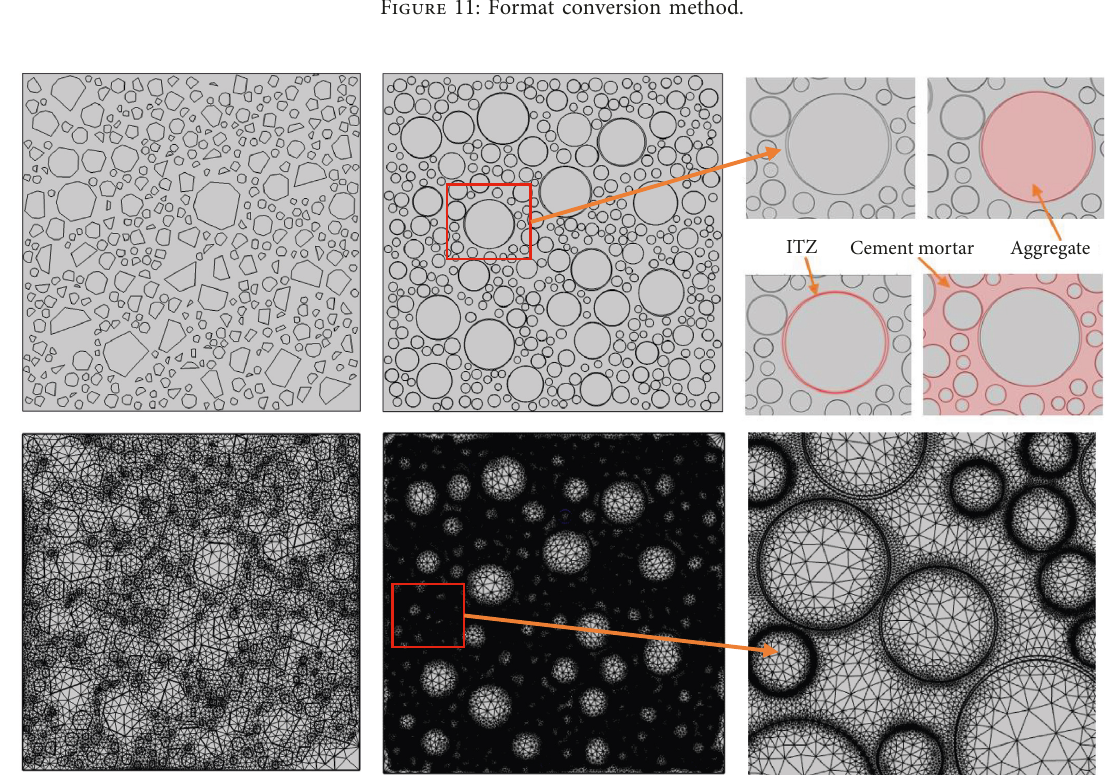
Figure 12: Mesh generation of random concrete